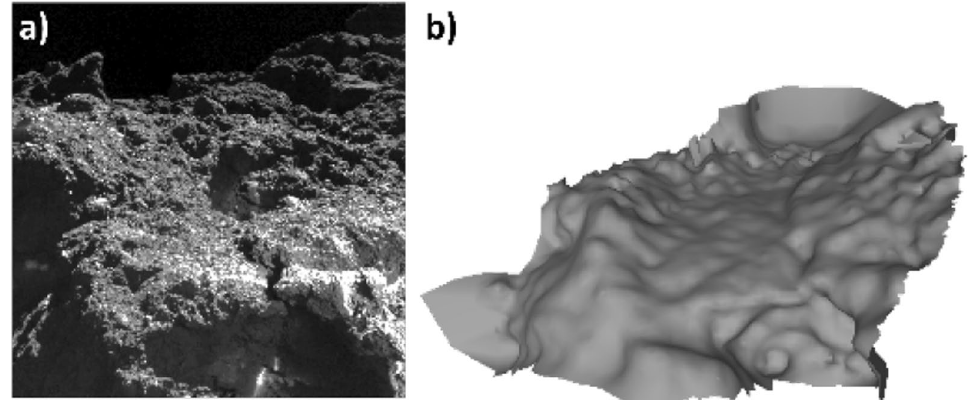
Fig. 2 a MASCOT’s landing site imaged by MasCam at day time and b shape model of the scene. The scene is approximately 25 cm across. The illuminated flat plateau (~ 15 cm across) is referred to as the MASCOT rock. The overexposed streaks in the foreground in a) are reflections of MASCOT’s